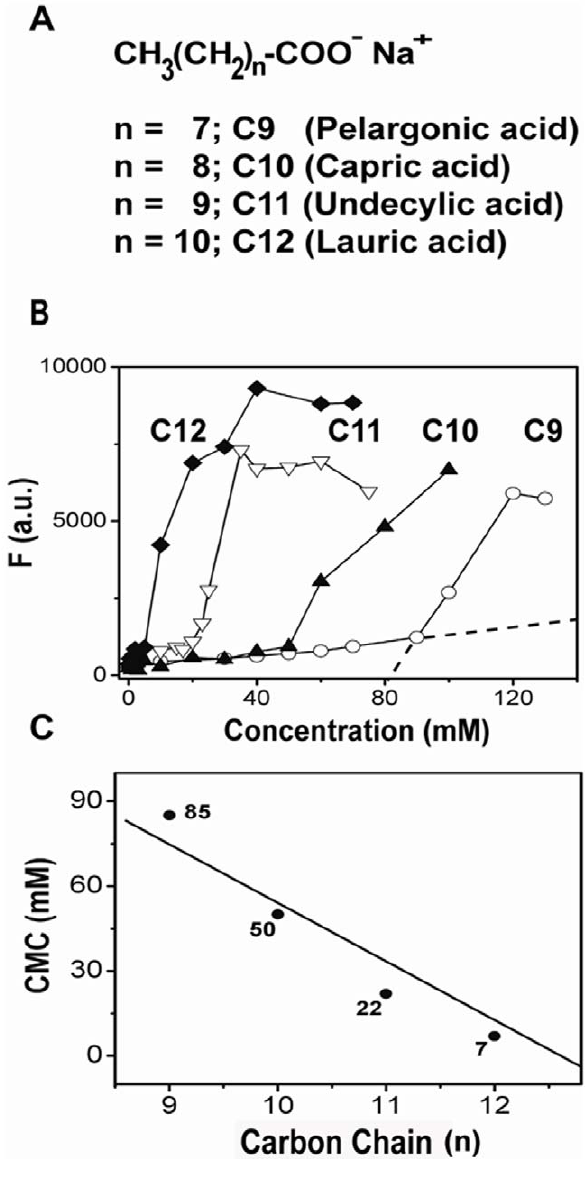
Figure 1. Critical micelle concentration (CMC) measurements of NEFAs used in this study. A) NEFAs used in this study: ‘n’ represents the carbon chain length, B) N-phenyl-1- naphthylamine (NPN) fluorescence response curves for fatty acids used in this study; C9 ( # ), C10 ( m ), C11 ( , ) & C12 ( ¤ ). Representative dotted lines for C9 shows the linear extrapolations of the curve to calculate CMC, which